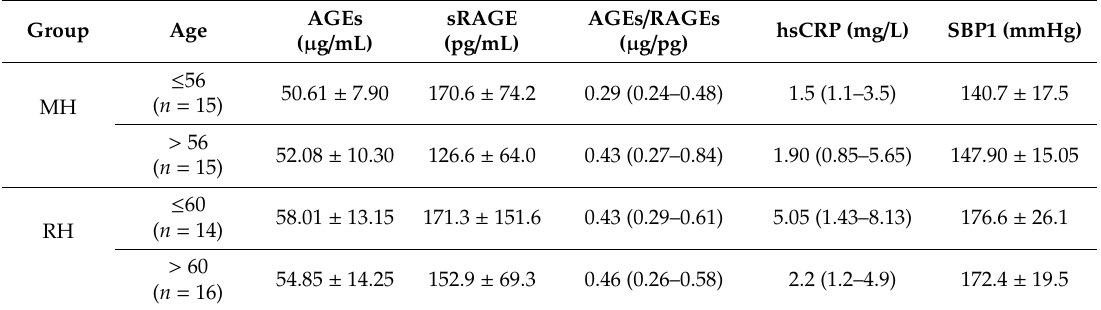
Table 5. The influence of age on AGEs, RAGEs, AGEs / RAGEs ratio, and SBP1 in MH and RH patients.